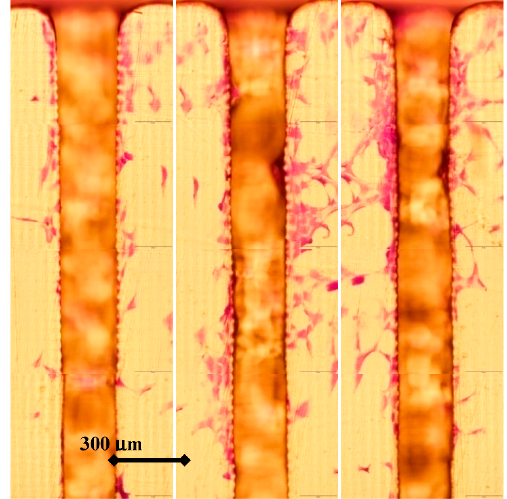
Figure 5. Detailed views of cells on the microsystem, escaping from the three rougher channels and migrating through their peripheries, after 24 h of motility study. The fractal dimension and roughness of the channels increases from left to right.